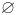
First row: low set; second row: high set.Third row: low set including the degradation effects. Ideal value: horizontal line; ideal method: dotted line; SP: solid line; SR: dashed line; DW: dotted–solid line, and no compensation applied (represented by the symbol ⌀): dot–dot–dash.